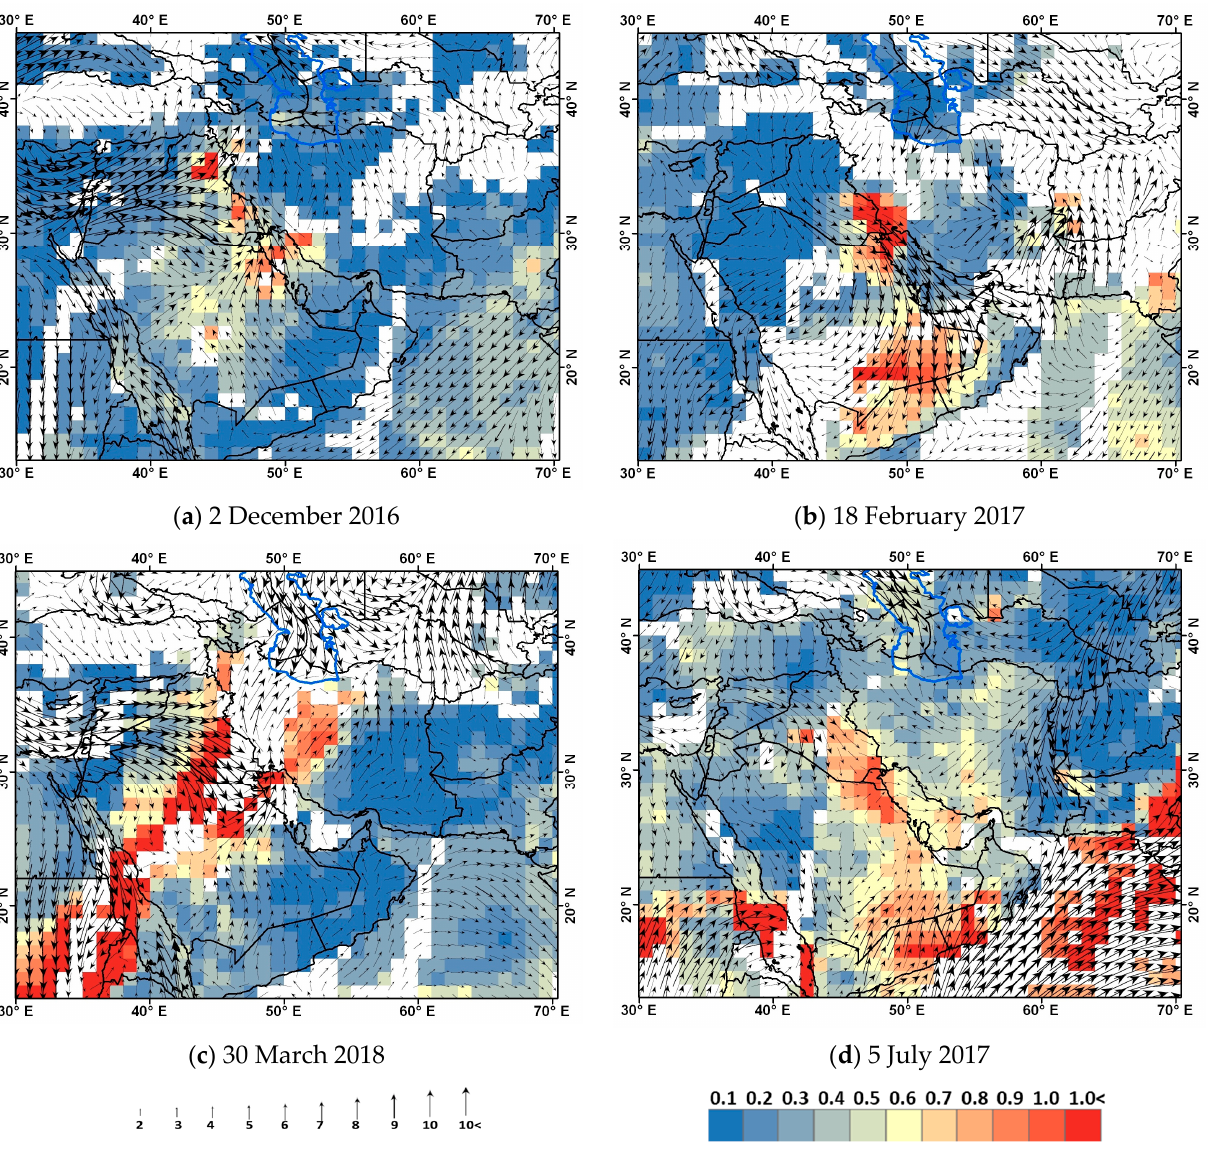
Figure 2. Terra-MODIS AOD 550 retrievals over the Middle East on ( a ) 2 December 2016 (cyclonic dust storm), ( b ) 18 February 2017 (post-frontal dust storm), ( c ) 30 March 2018 (pre-frontal dust storm), ( d ) 5 July 2017 (Shamal dust storm). White areas denote lack of data due to cloud contamination. The overlaid wind vectors correspond to surface winds taken from ERA-Interim reanalysis.